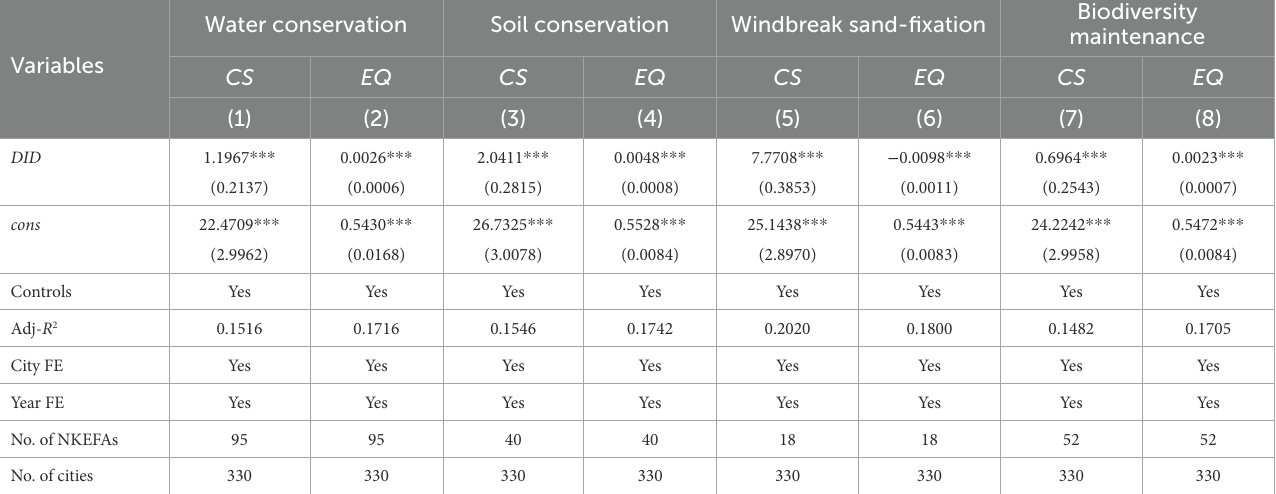
TABLE 5 Heterogeneity analysis: differences based on function type. Water conservation Soil Variables